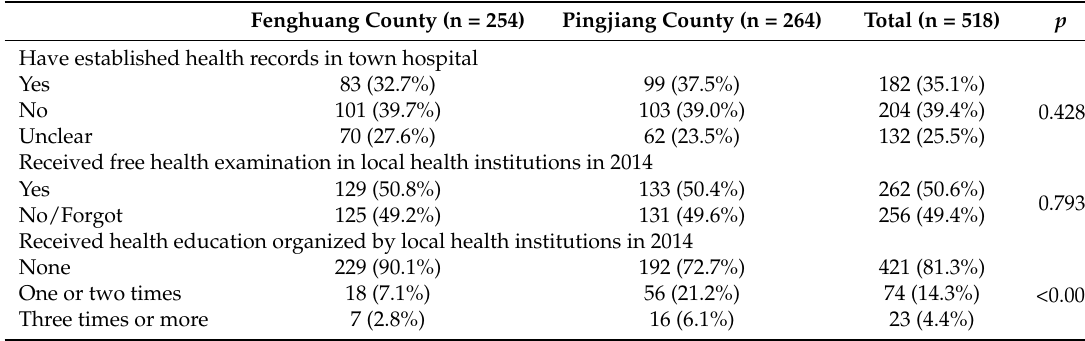
Table 5. Received basic public health services among CLBC (n,